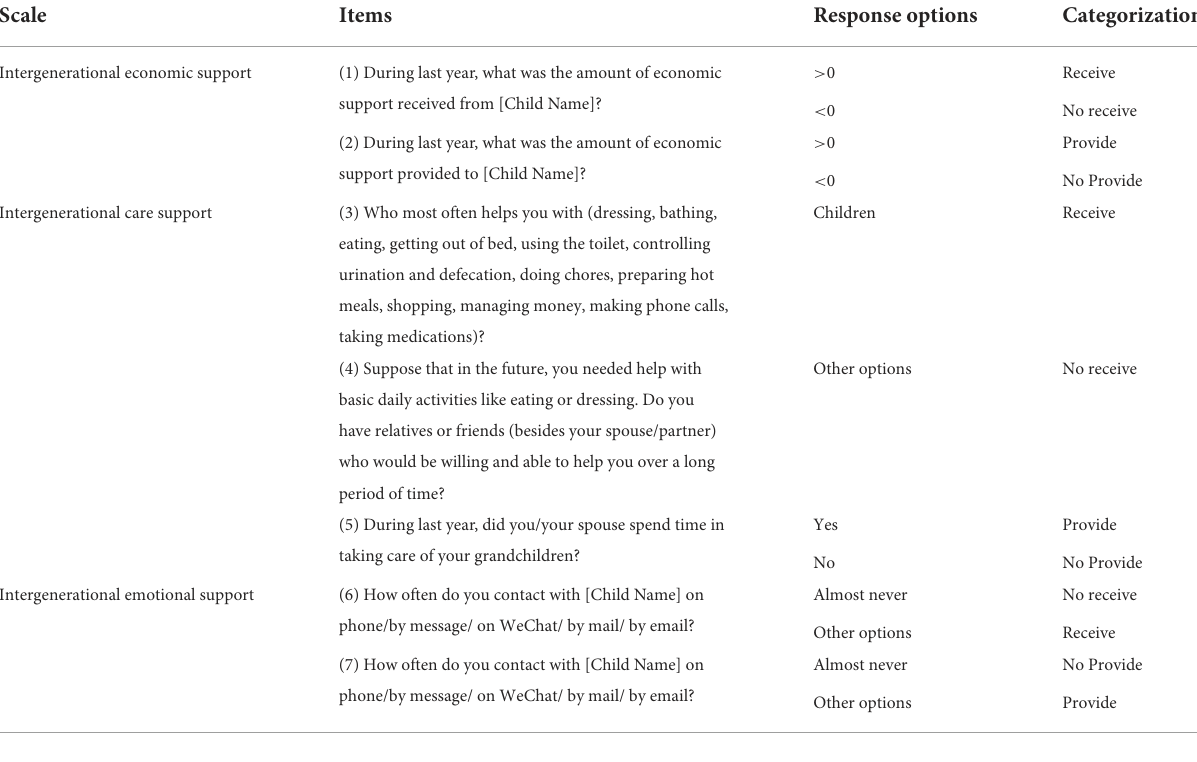
TABLE 3 Variables and